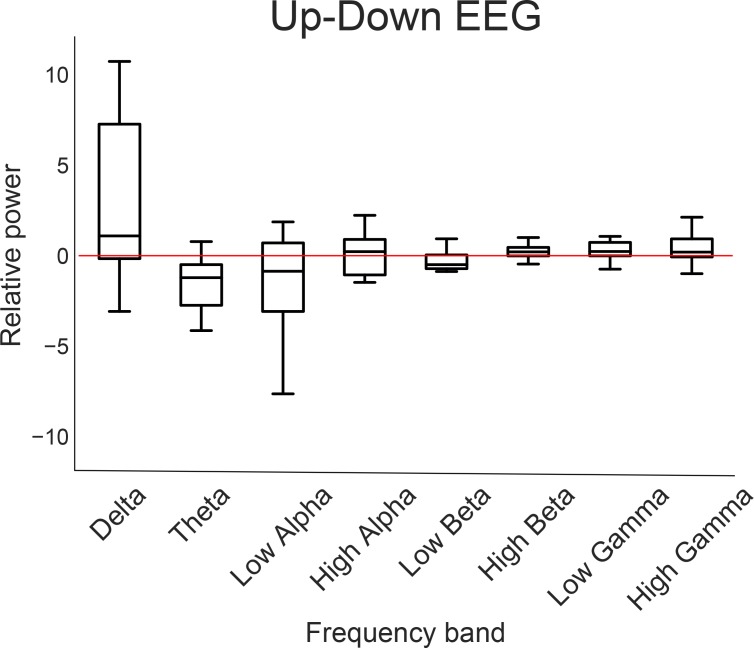
Boxplots showing relative power in the Up condition minus the Down condition for the electrode corresponding to the hotspot in the opposite (non-feedback) hemisphere.